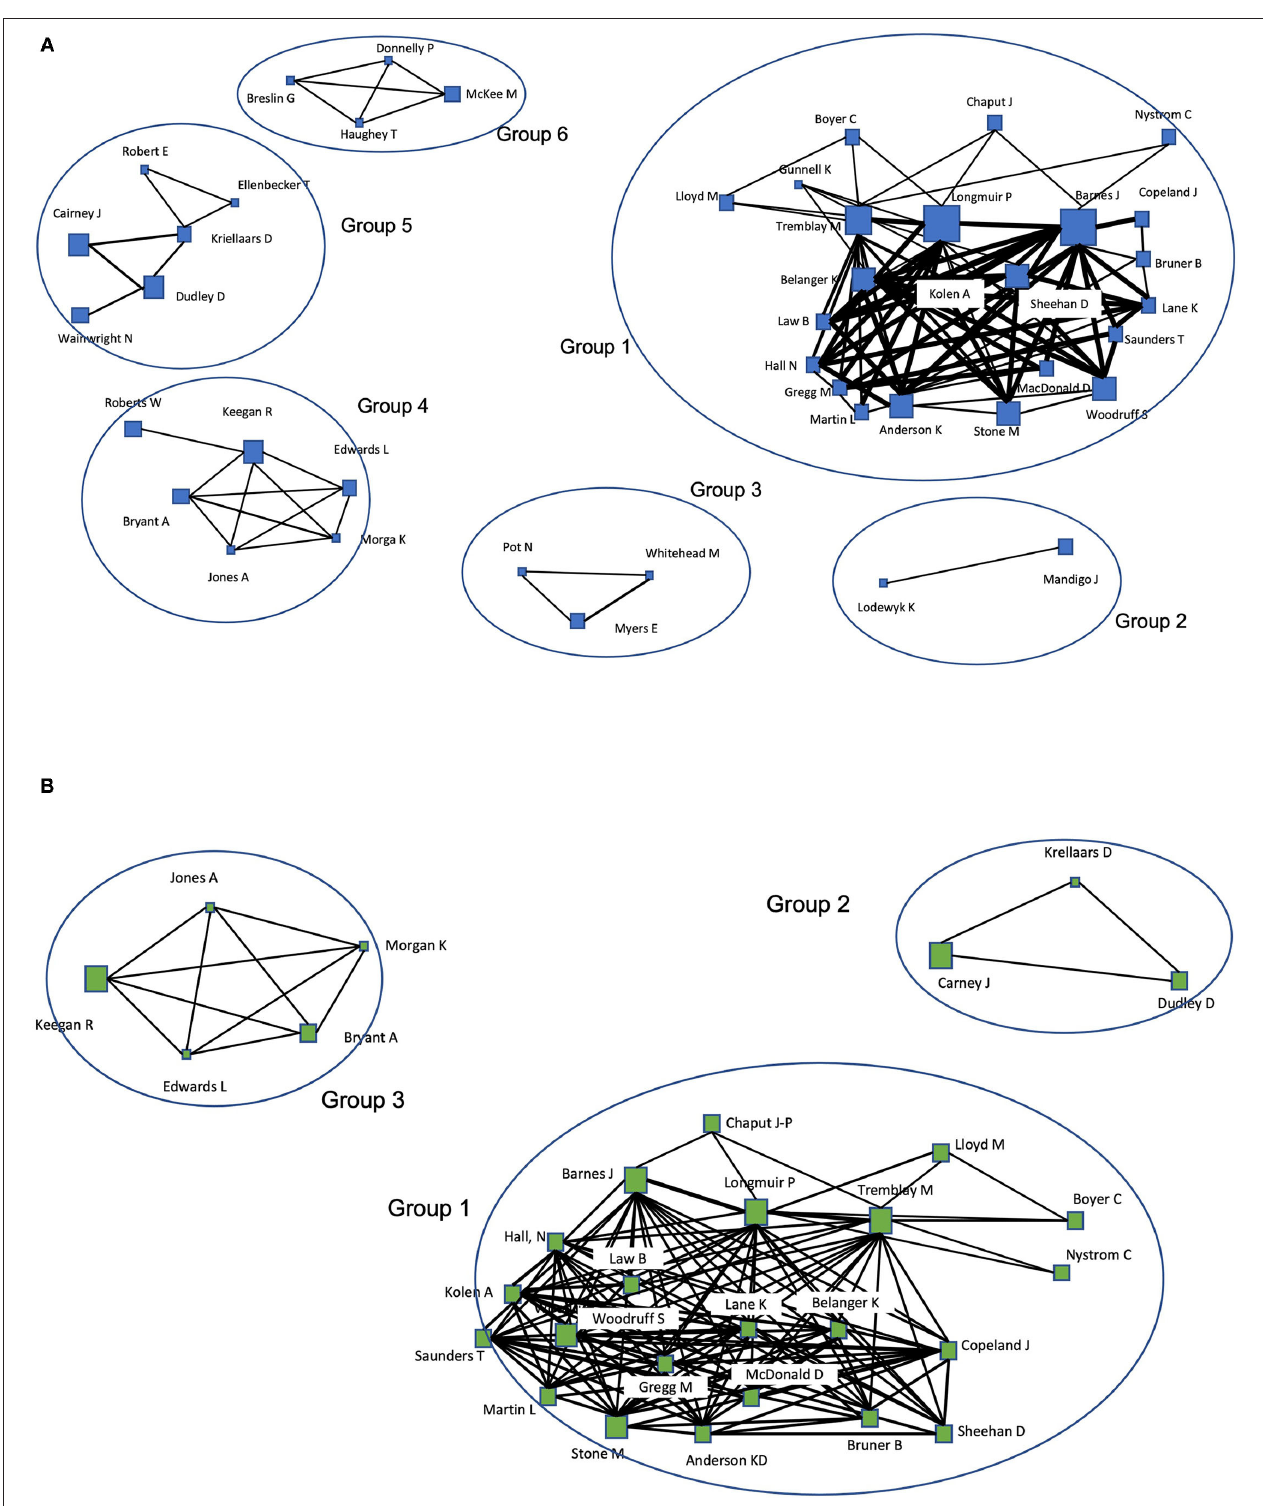
FIGURE 3 | (A) The co-authorship network of the empirical sub-network. (B) The co-authorship network of the empirical sub-network with only the nodes (actors) coauthored more than twice.